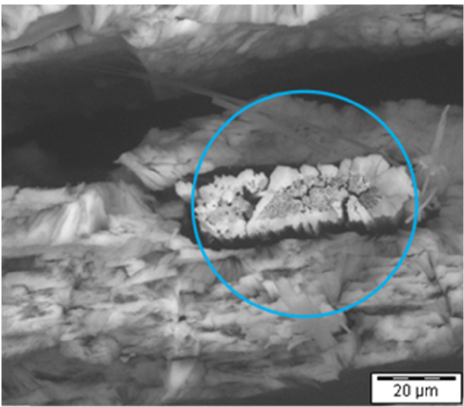
Figure 10. α -HH formed in gypsum crystal (blue circle) beside β -HH.